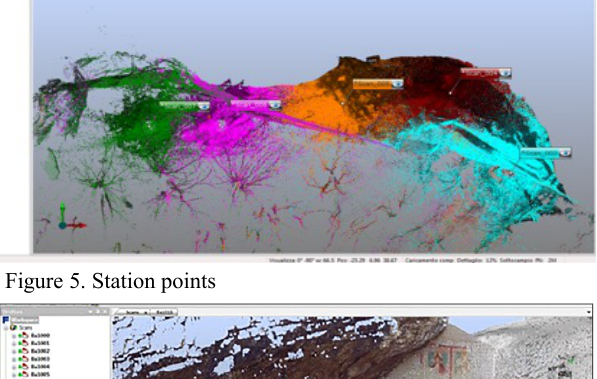
Figure 5. Station points